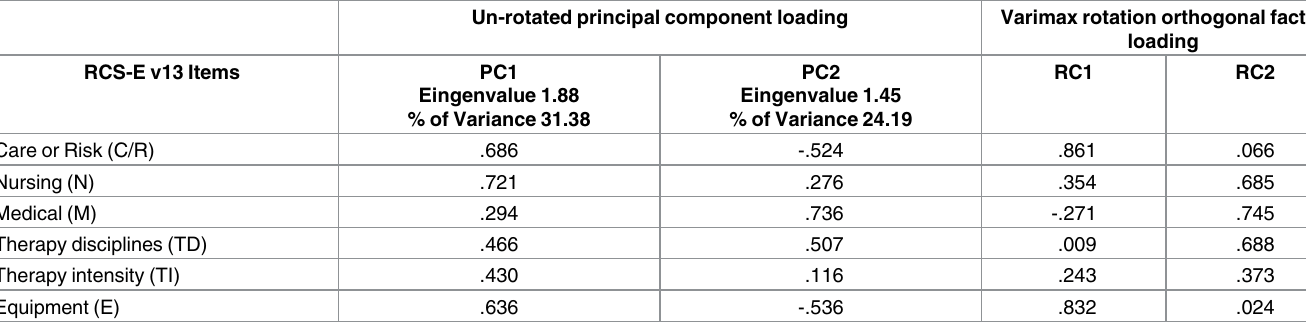
Table 3. Results of principal component factor analysis of the RCS-E v13 items.